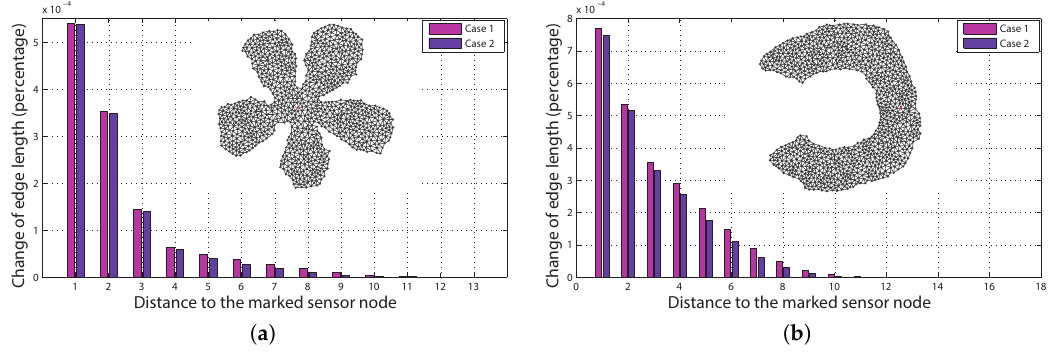
Figure 11. The error of the computed edge length decreases dramatically with its distance to the distorted node marked with